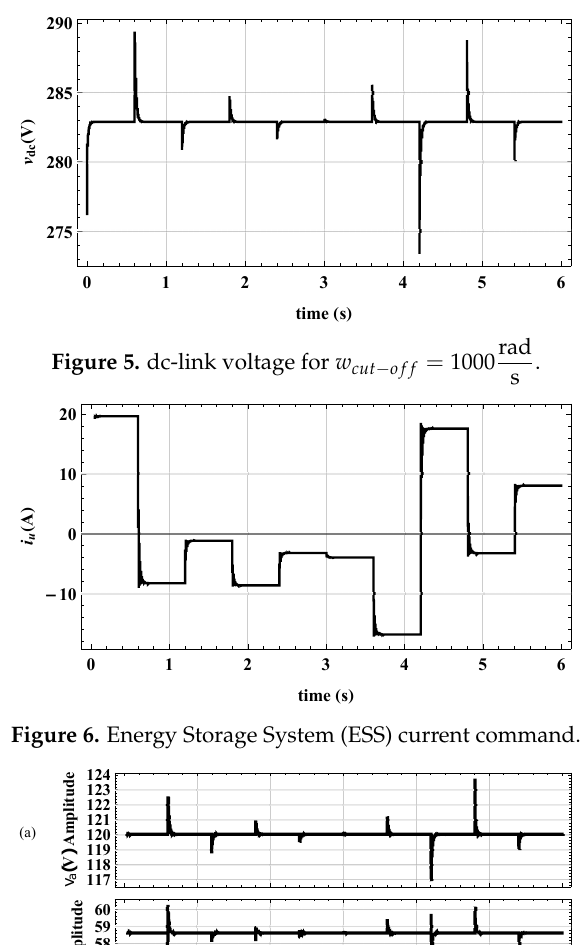
Figure 6. Energy Storage System (ESS) current command.